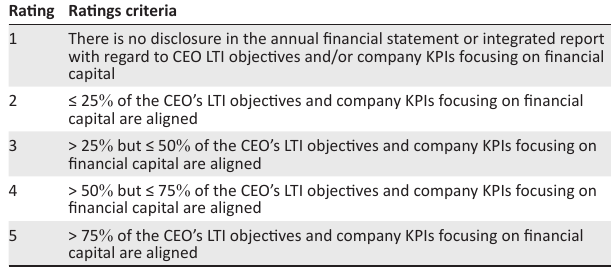
TABLE 2: Ratings analysis.